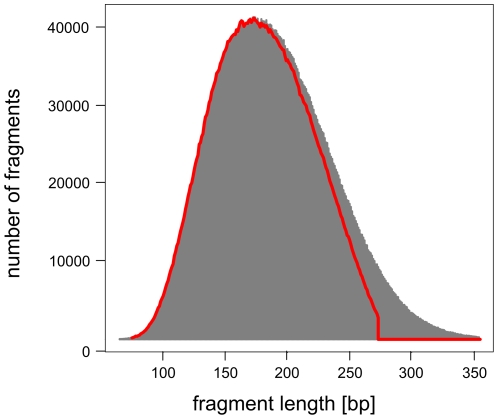
High-confidence alignment yield by insert lengths.Distribution of insert lengths by aligning the original reads to the reference sequence (gray), and lengths of composite reads retained (red).